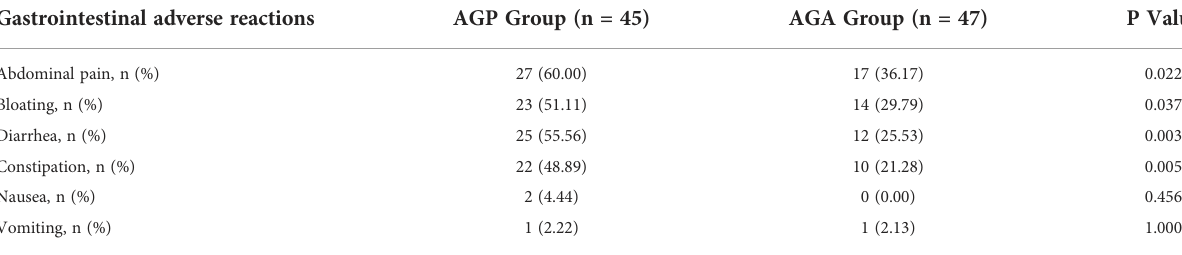
TABLE 2 The occurrence of postoperative gastrointentional adverse reactions in patients. Gastrointestinal adverse reactions